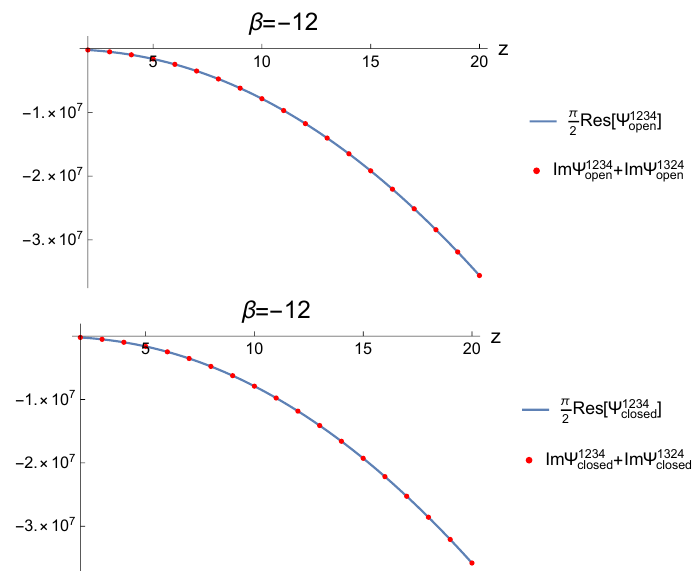
Figure 9: The comparison between the analytic formula for the residue at β = − 10 and the numerical evaluation of the imaginary part for the open and closed string celestial